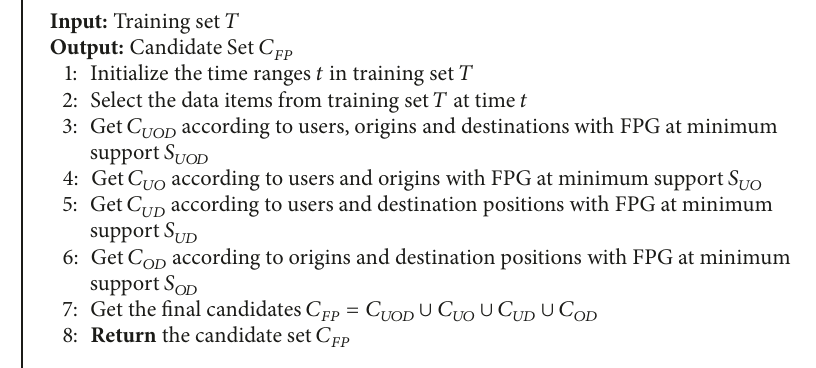
Algorithm 1: Candidate generation algorithm.